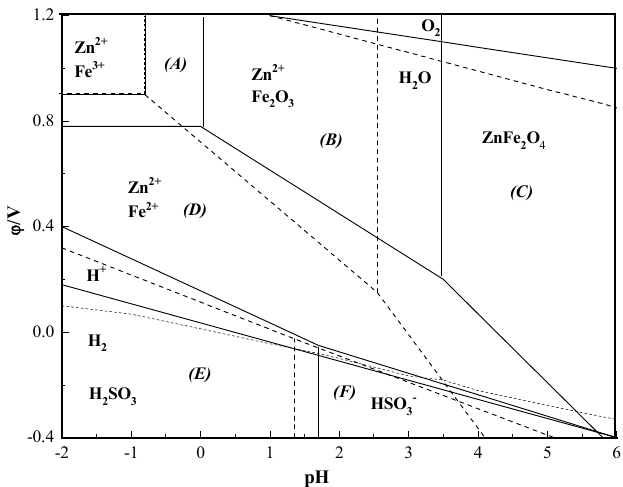
Figure 7. Predominance diagram of φ -pH for SO 2 -ZnFe 2 O 4 -H 2 O system (25 °C—Full lines, 100 °C—Dashed lines).